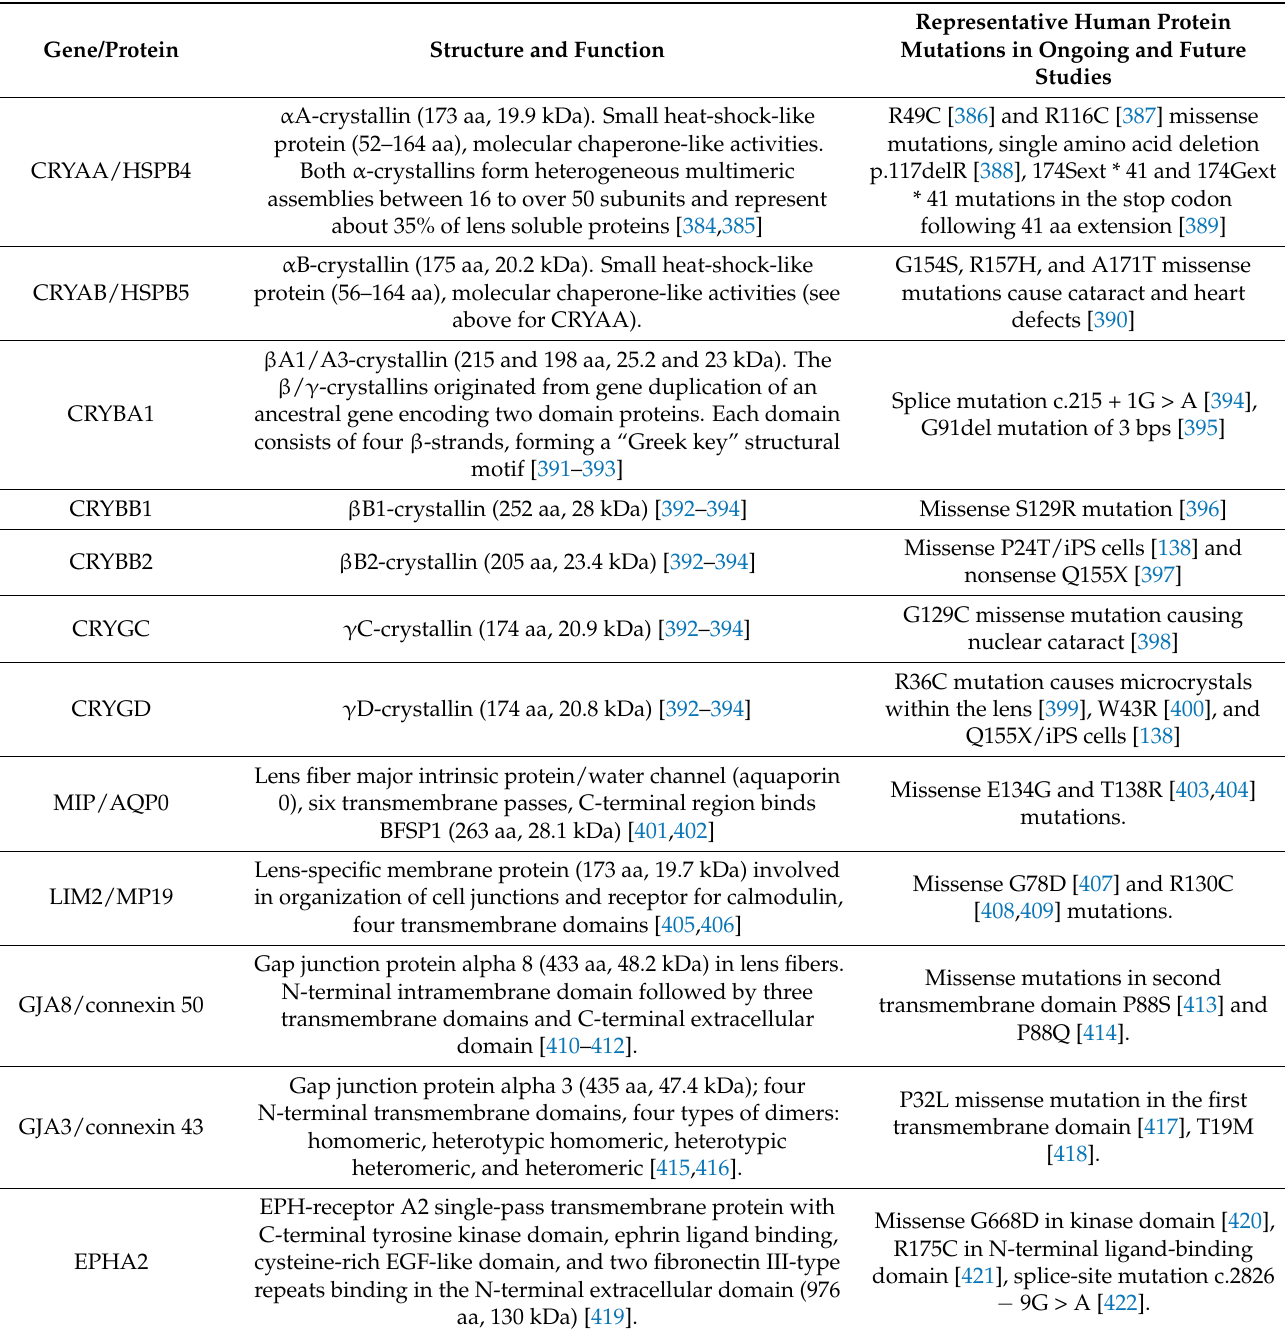
Table 5. Examples of mutated cataract genes encoding lens structural proteins and their cur- rent/future models in lentoid